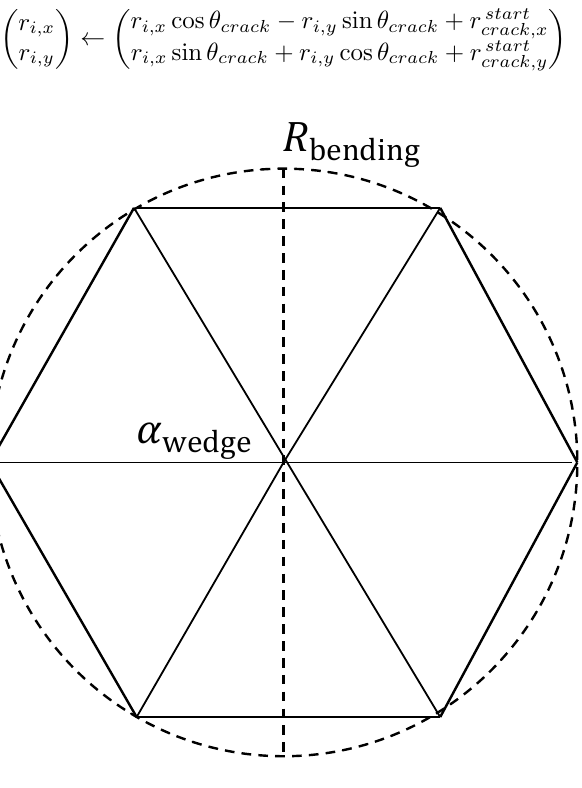
Figure 25: Segmentation of a circle into ice wedges. An example of N wedges = 3 and α wedge = π/